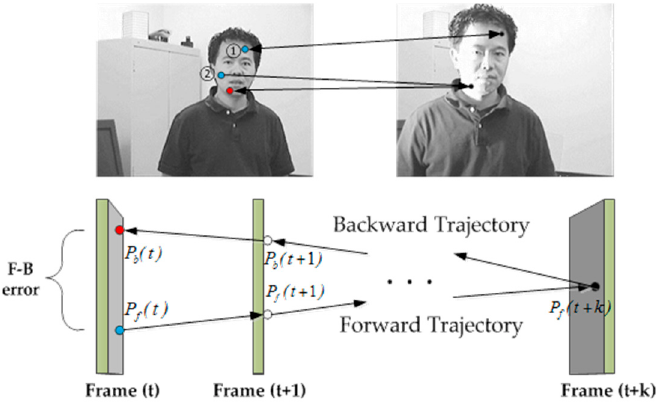
Figure 2 . Illustration of the Forward–Backward error.